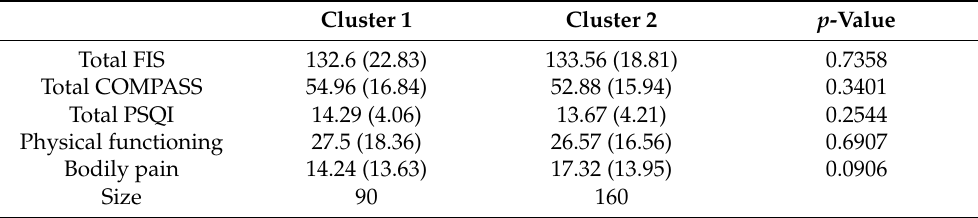
Table 5. Symptom differences between case clusters with increased C1q values (cluster1) (>26.05 mg/dL) or within range (C1q < 26.05 mg/dL). Group mean values and standard devia- tions are shown.